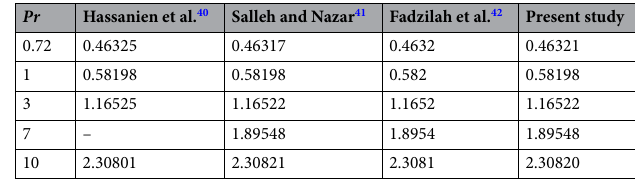
Table 1. Comparison results of � ′ ( 0 ) in the absence of the n , We , M , R , Nb , Nt , Q , Du .